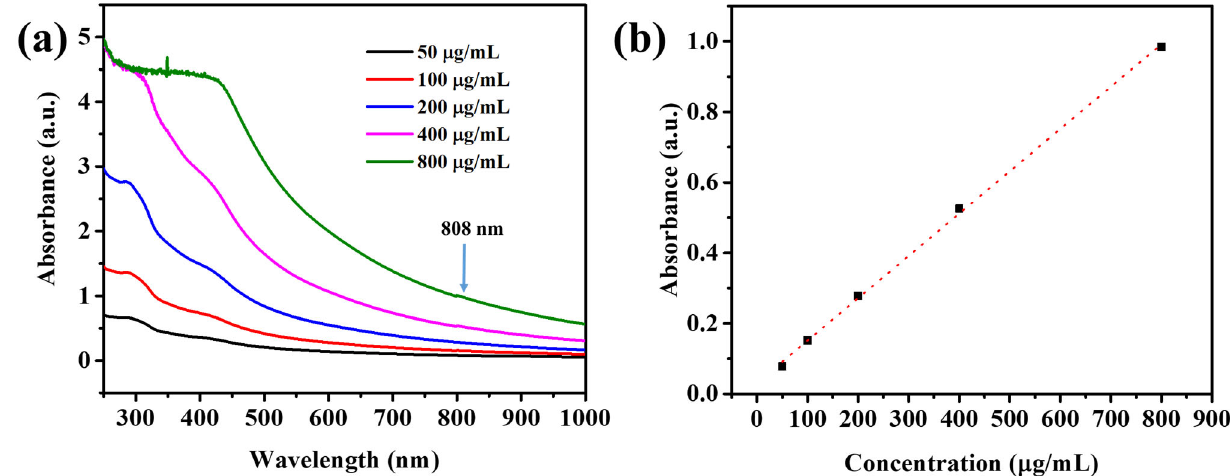
Figure 2. ( a ) UV-Vis-NIR absorption of FCPDA nanoparticles (50–800 µg/mL), and ( b ) graph shows the linear connection between absorbance and FCPDA nanoparticle concentration at a wavelength of 808 nm.